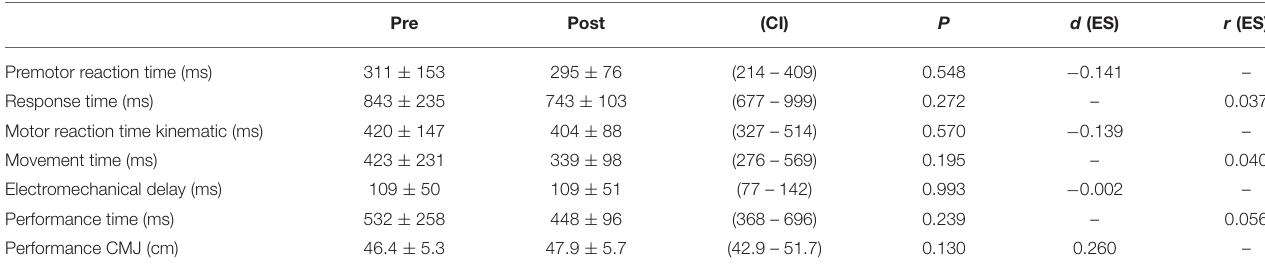
TABLE 4 | Mean and standard deviation and the effect size (ES) of the parameters associated with the neuromuscular and motor performance of the roundhouse kick during the evaluation pre and post the training of pace rounds in taekwondo athletes ( n =